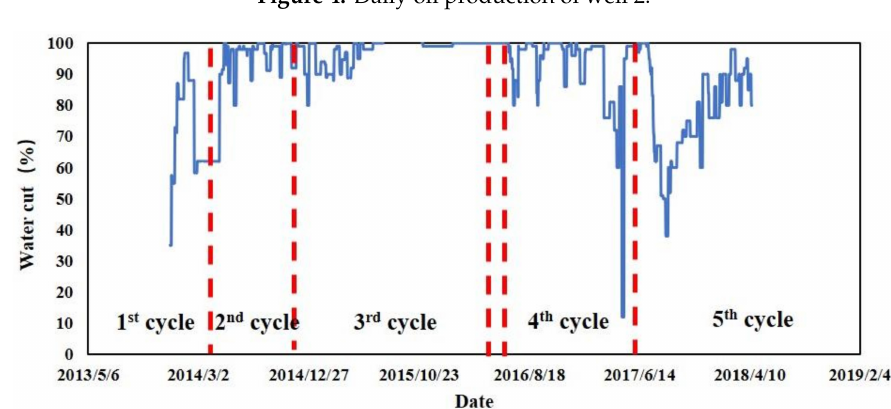
Figure 4. Daily oil production of well 2.